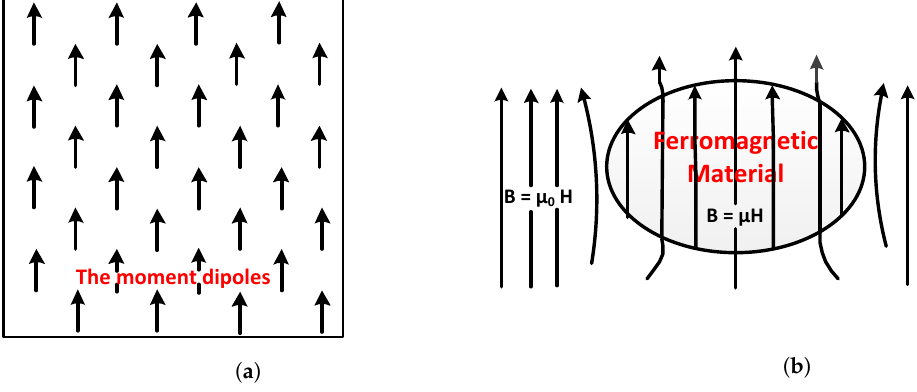
Figure 4. Ferromagnetic material characteristics. ( a ) Moment dipoles. ( b ) Flux inside and outside the